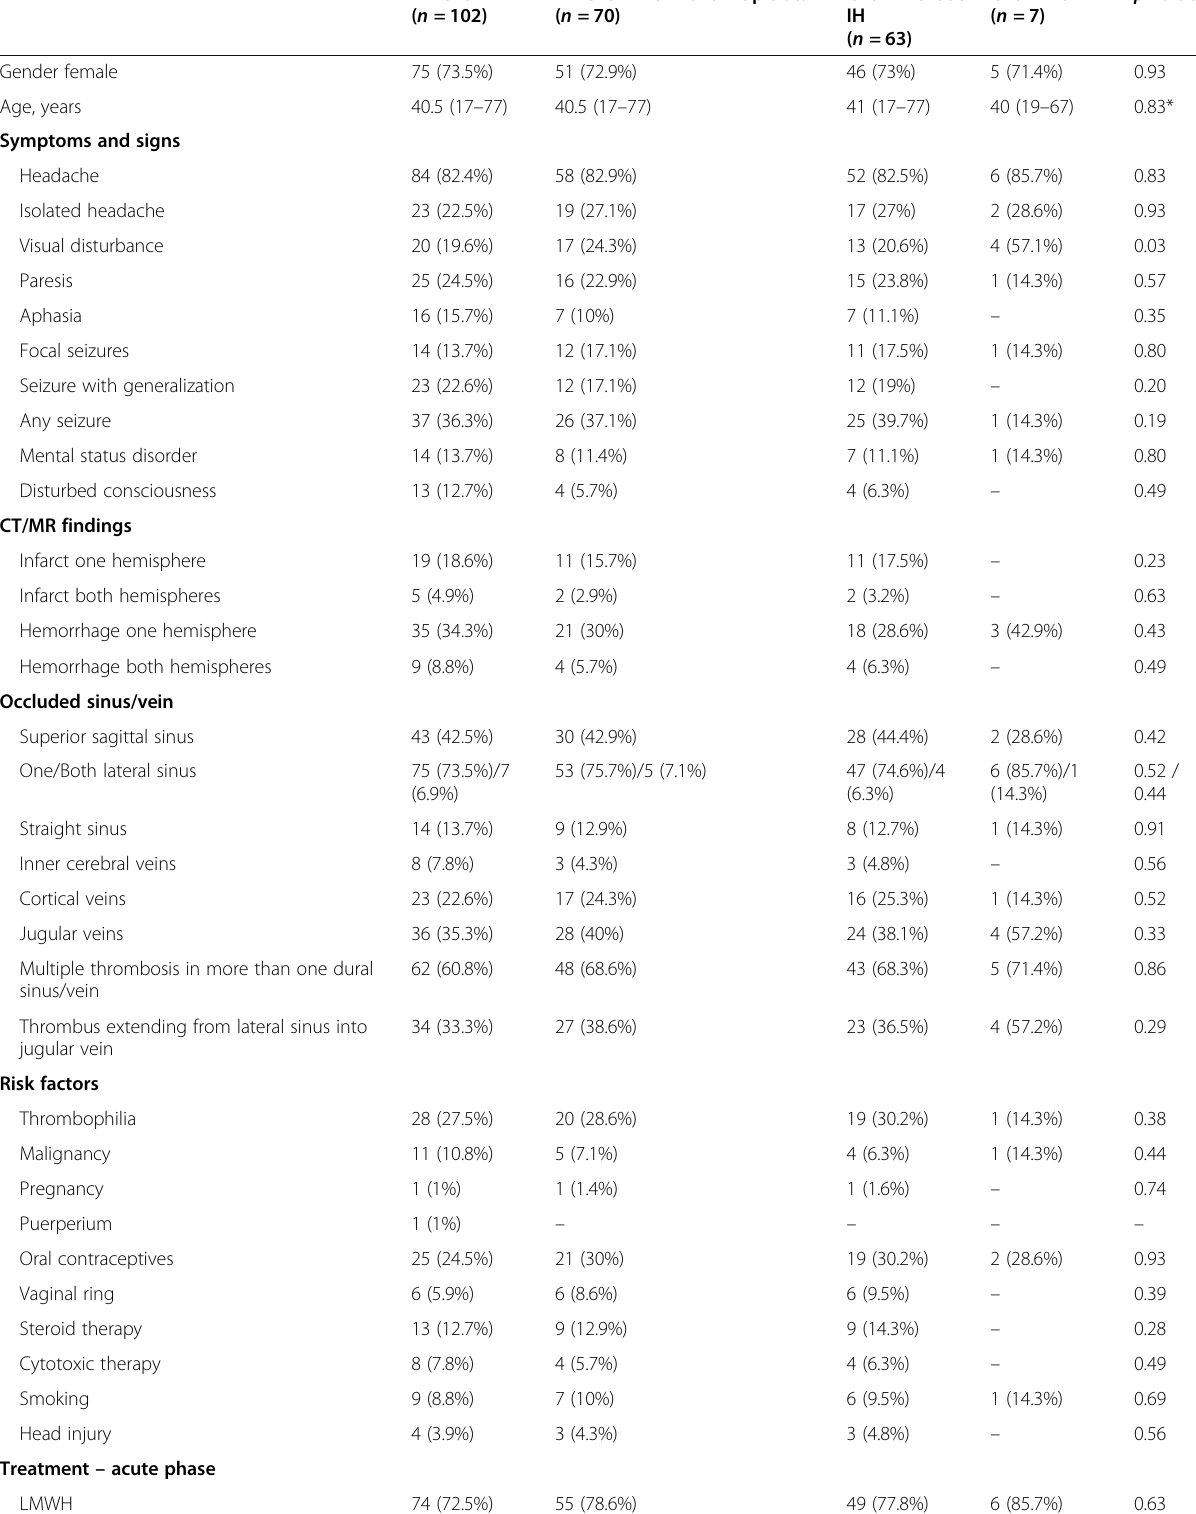
Table 2 Characteristics of all CVST-patients, all CVST-patients with Follow-up Data, CVST- patients without IH and with IH. Age is expressed as median (min-max) with *Mann-Whitney-U-Test, categorical data expressed as n (%) with